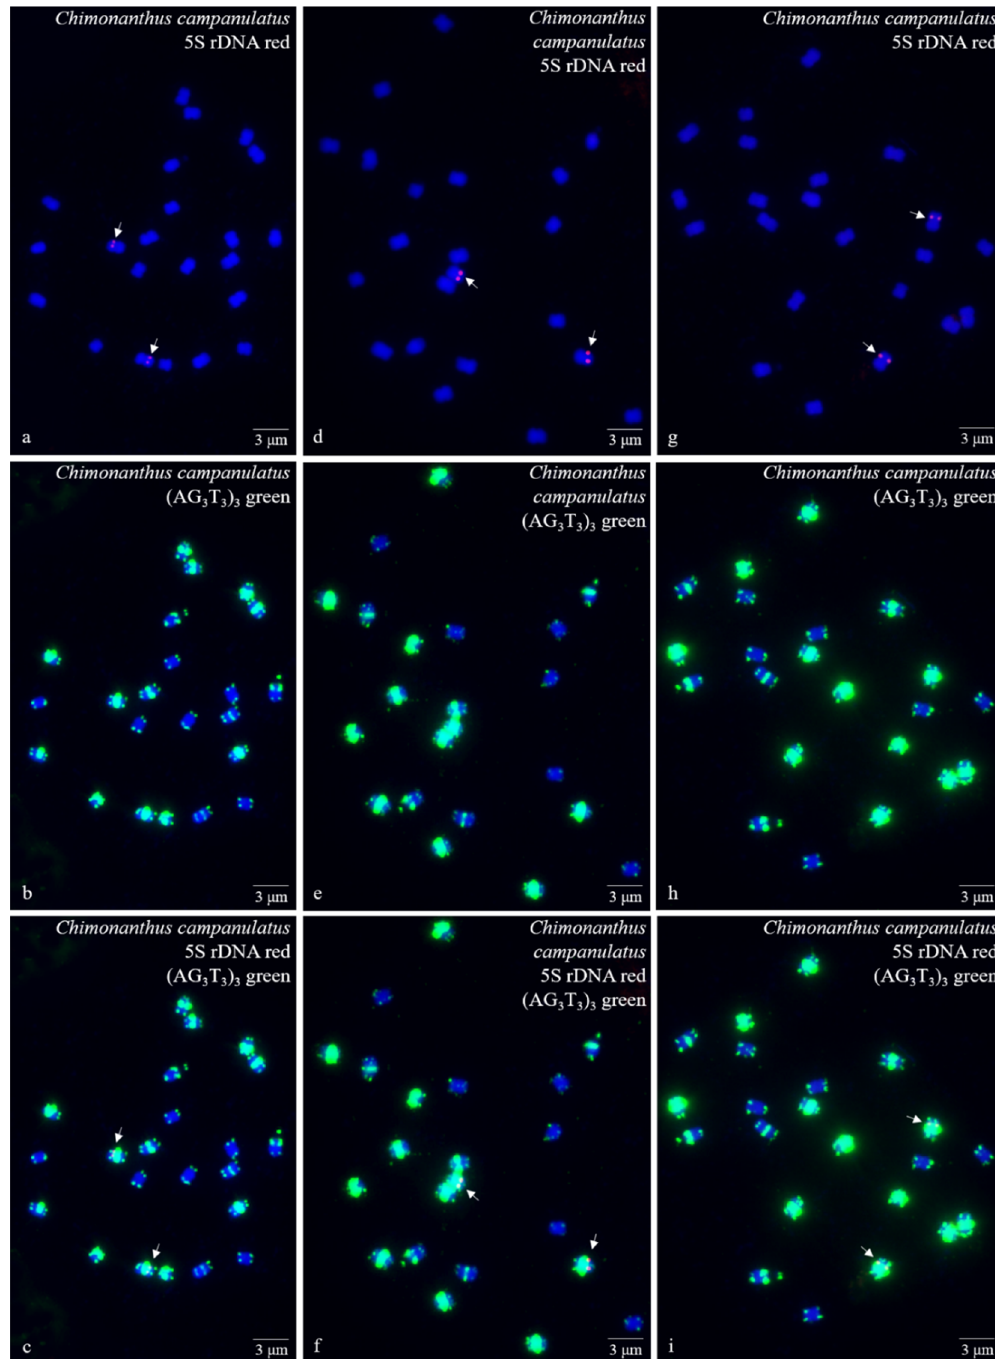
Figure 1. Mitotic metaphase (preliminary stage) chromosomes of Chimonanthus campanulatus R.H. Chang & C.S. Ding after fluorescence in situ hybridization (FISH). Three spreads are presented in Figure 1 a – c , Figure 1 d – f , and Figure 1 g – i . The probe oligo – 5S rDNA result with chromosomes visualized by carboxytetramethylrhodamine (TAMRA) (red, white arrows) is shown in Figure 1 a , c , d , f , g , i , whereas the probe oligo – (AG 3 T 3 ) 3 result with chromosomes visualized by carboxyfluorescein (FAM) (green) is shown in Figure 1 b , c , e , f , h , i . Chromosomes were counterstained by 4,6-diamidino-2-phenylindole (DAPI) (blue) in all images. Scale bar = 3 μ M.